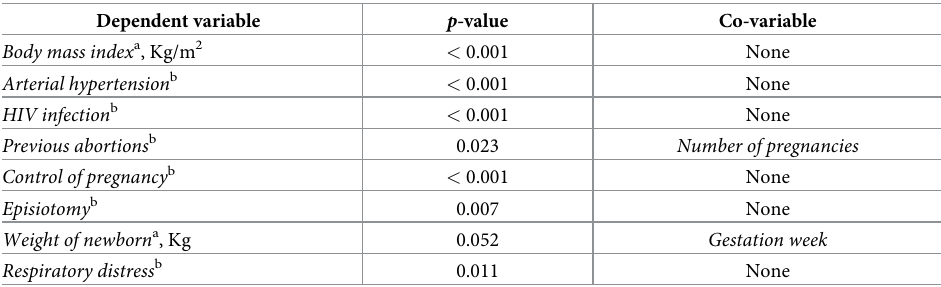
Table 5. Additive models for the effects of the age on several factors.